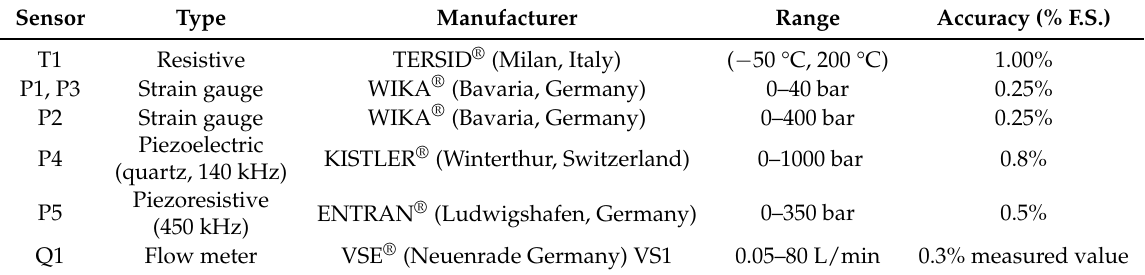
Table 2. Description of the sensors used in the experiment [12].